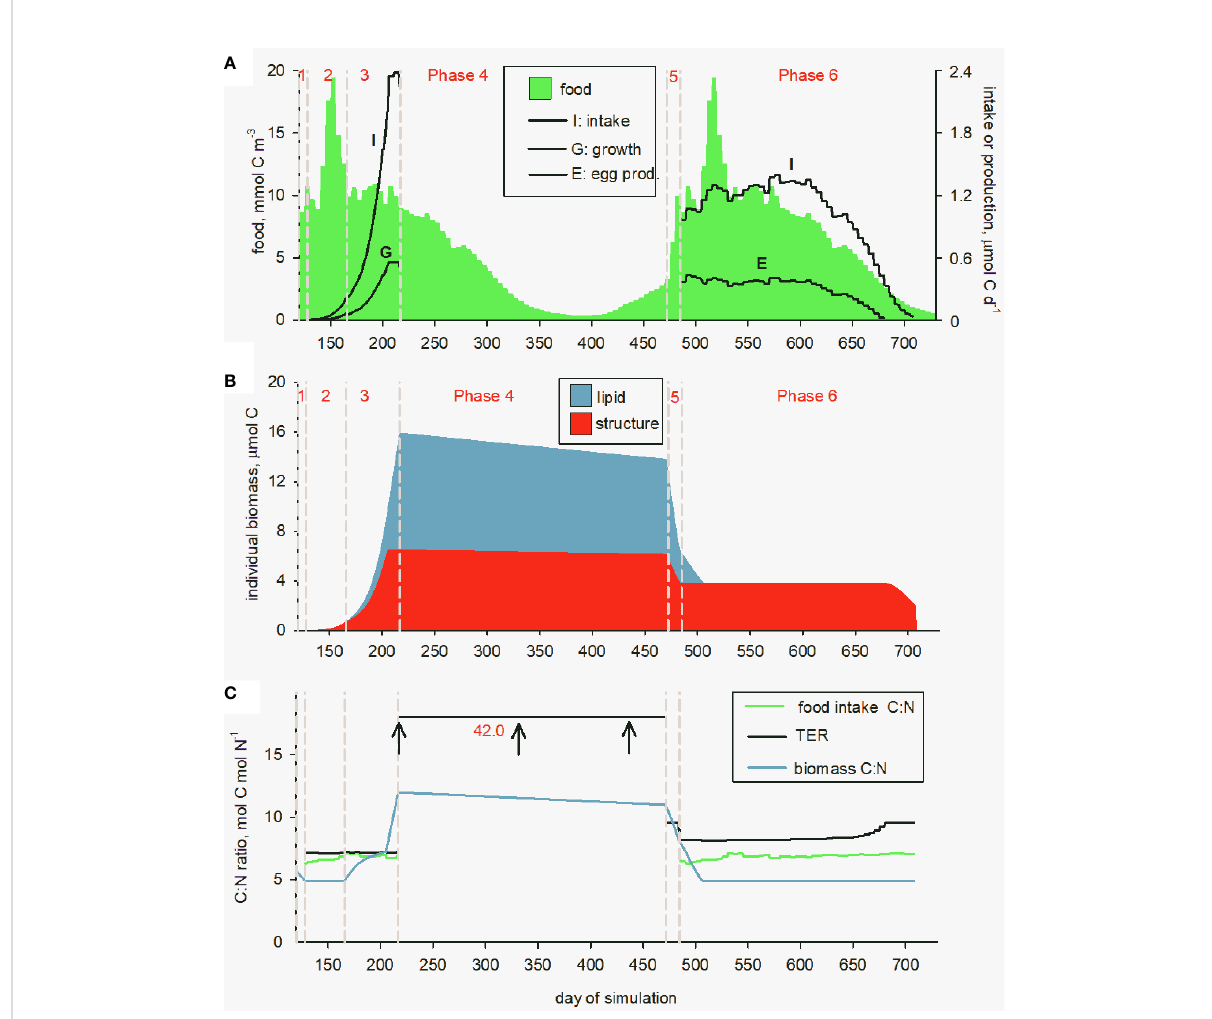
FIGURE 4 Predicted development of a C. fi nmarchicus individual throughout its life cycle at Station Mike. (A) Intake (I), growth (G) and egg production (E), along with the concentration of available food from the MEDUSA model output (green); (B) structural biomass (red) and lipid reserves (blue); (C) comparison of C:N ratios for food intake (green), copepod biomass (structure + lipid; blue) and the Threshold Elemental Ratio (TER;